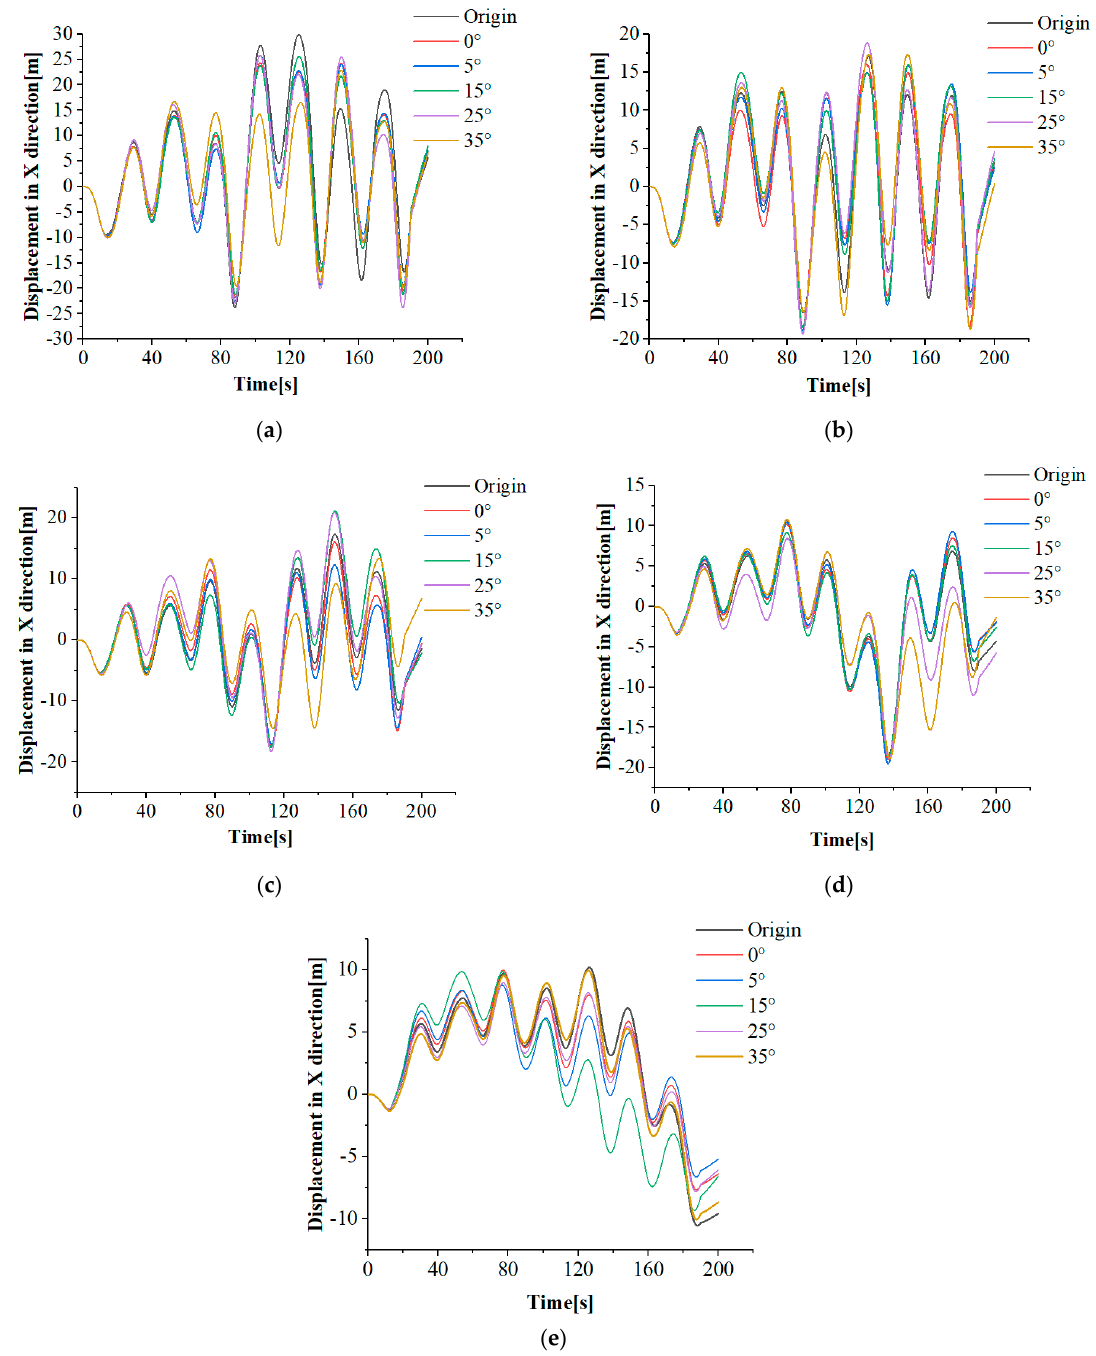
Figure 28. X direction displacement of the pedestal under different chamfers. ( a ) H = 9 m; ( b ) H = 7.2 m; ( c ) H = 5.4 m; ( d ) H = 3.6 m; ( e ) H = 1.8 m. Process the data in Figure 28 and subtract the movement of the model in the X direction for each perforation case from the original non-perforation model, and calculate its average absolute deviation to avoid the problem of deviation offset. The relevant data are shown in Table 5.